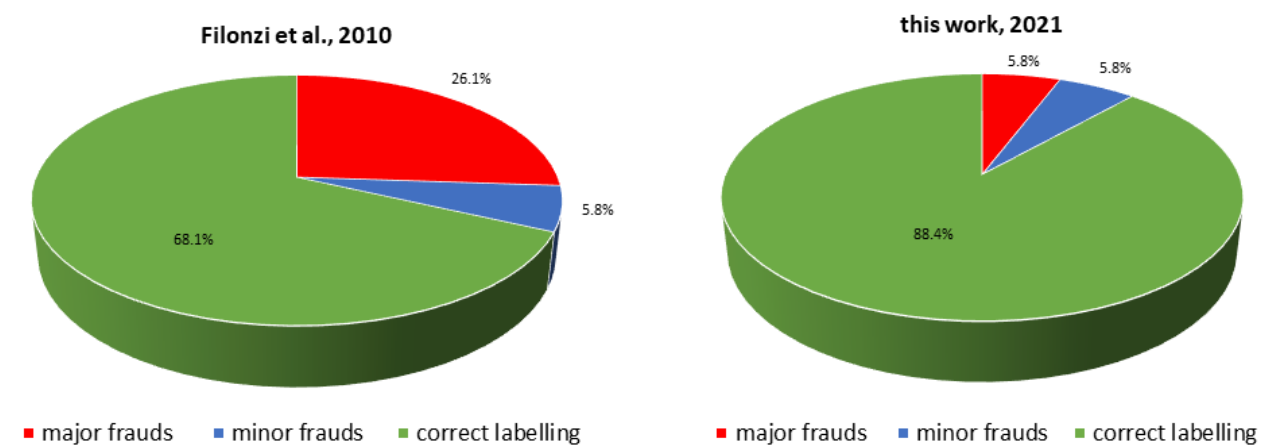
Figure 1. Comparison of percentages of species substitutions, both as major and minor frauds, assessed in 2010 and in the present work.